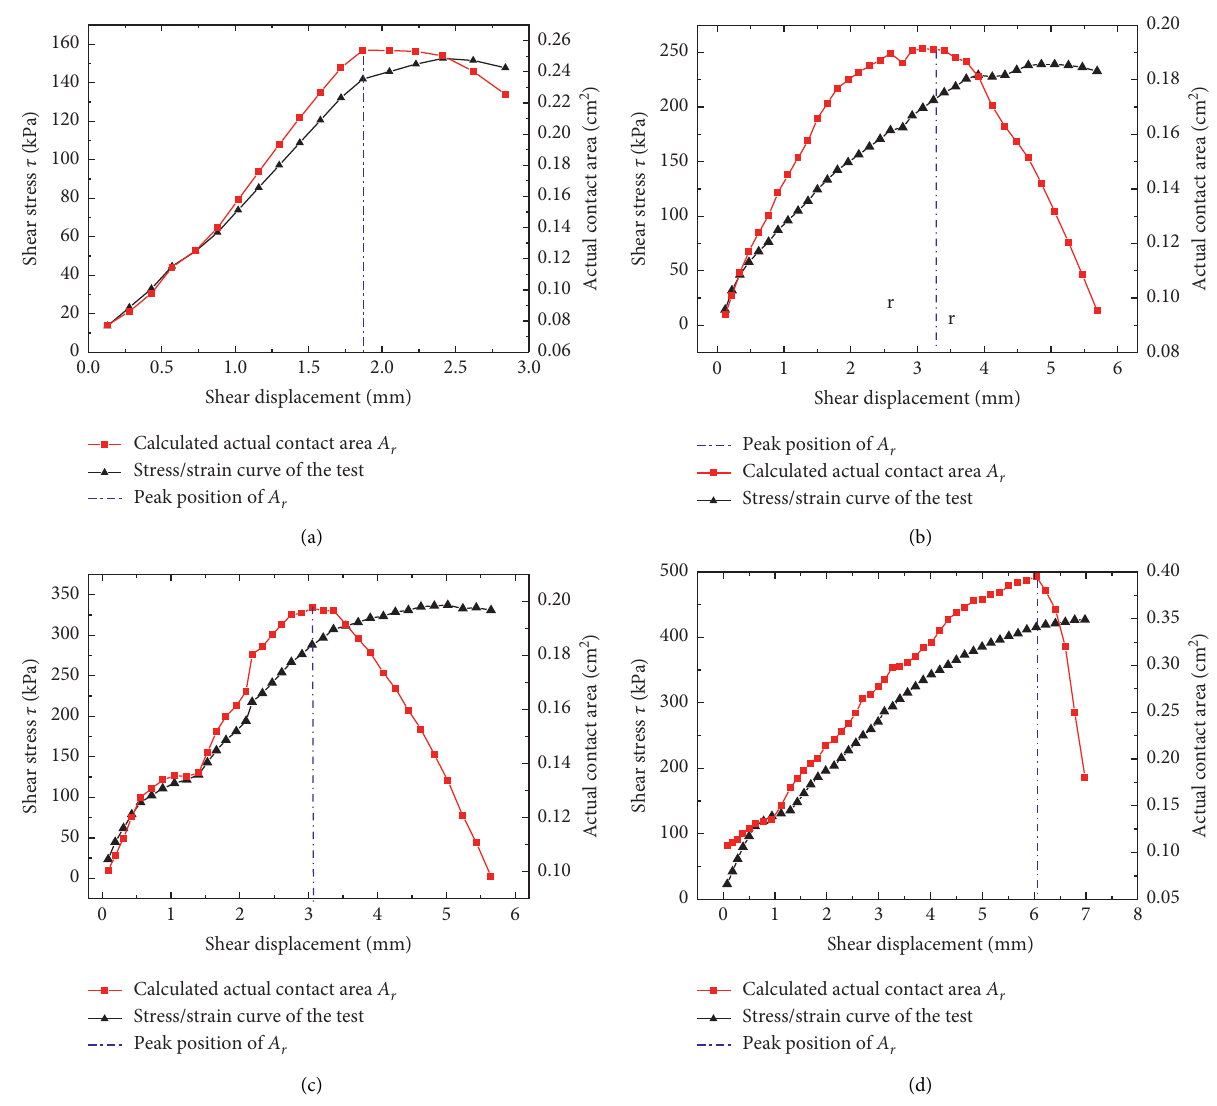
Figure 6: Relationship between shear strength and actual contact area: (a) vertical stress 100 kPa, (b) vertical stress 200kPa, (c) vertical stress 300kPa, and (d) vertical stress